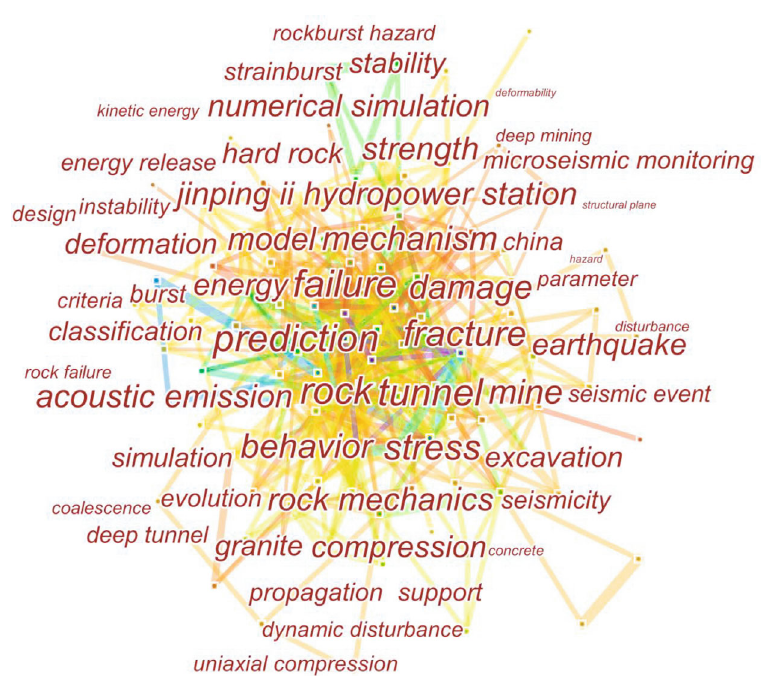
Figure 8: Keyword cooccurrence